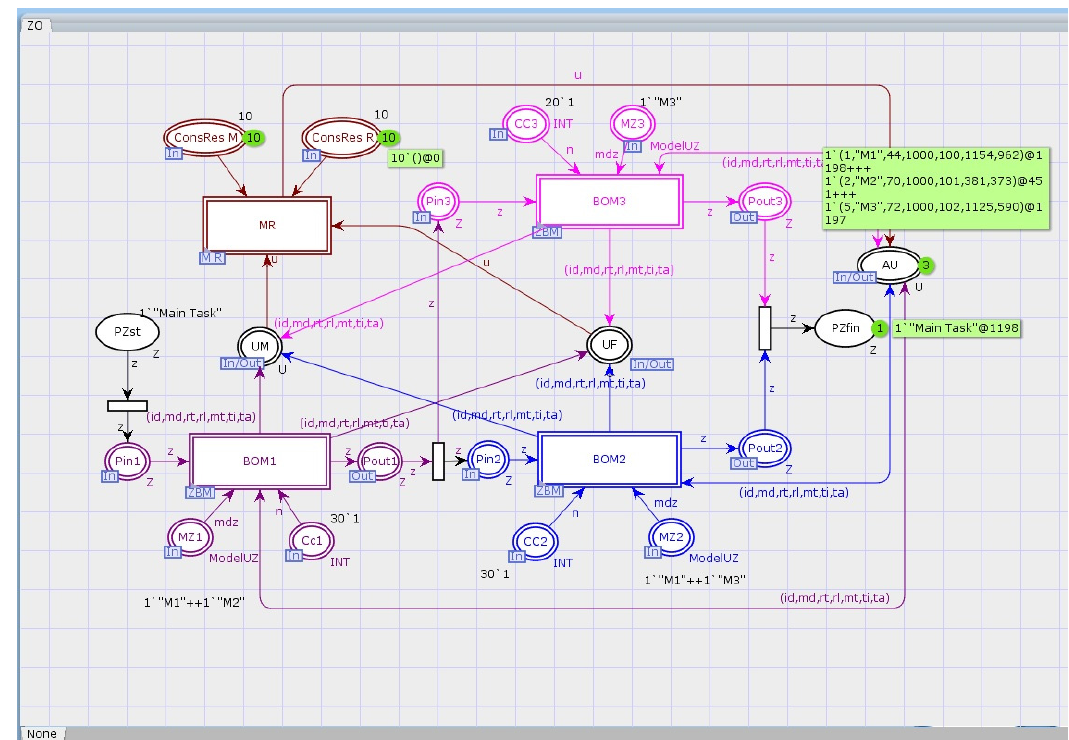
Figure A4. HPN AV final marking.